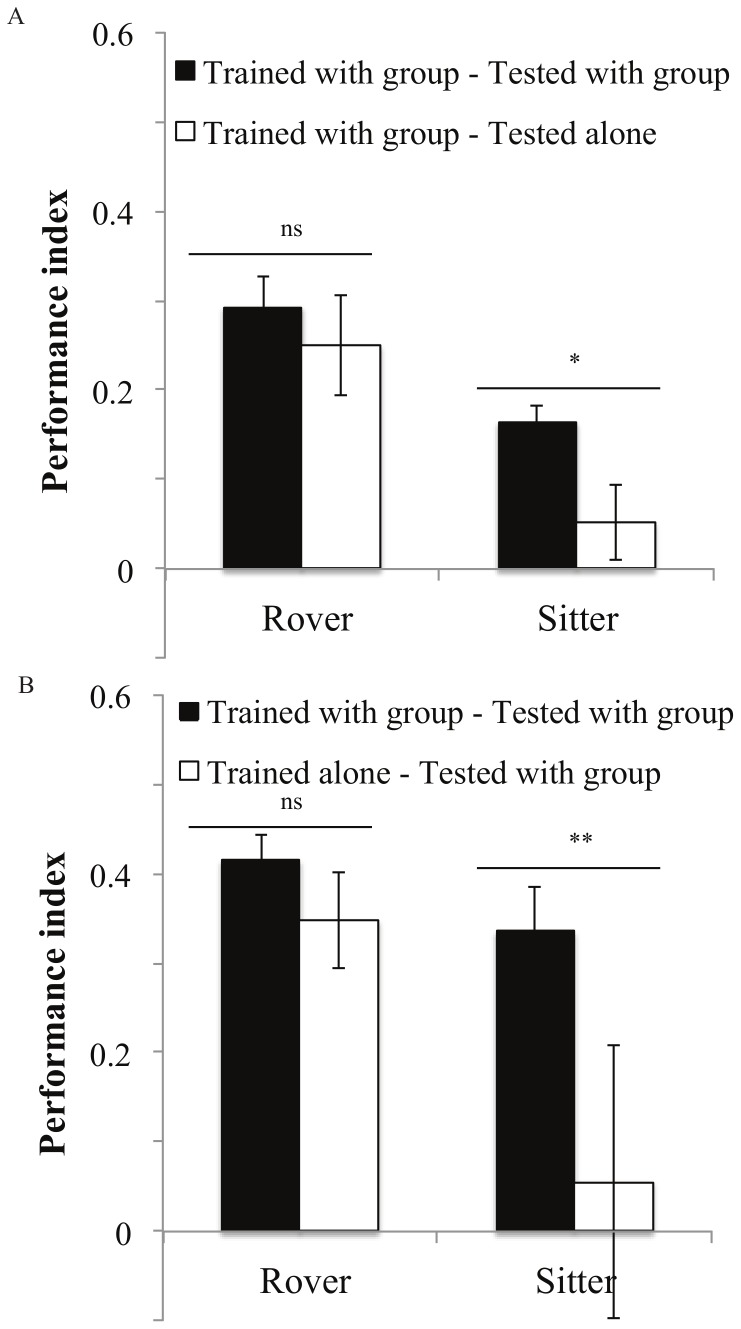
Performance of rovers and sitters when the training and testing were performed under different social contexts.
A: flies were trained in groups and then either tested in groups of the same genotype or individually. Rover: group: PI = 0.3±0.03 N = 23 PI; alone: PI = 0.25±0.05 N = 12 PI. Sitter: group: PI = 0.16±0.01 N = 24 PI; alone: PI = 0.05±0.04 N = 16 PI. B: flies were trained individually or in groups and then tested within a trained group of the same genotype. Rover: group: PI = 0.41±0.03 N = 25 PI; alone: PI = 0.34±0.05 N = 7 PI. Sitter: group: PI = 0.33±0.05 N = 21 PI; alone: PI = 0.05±0.15 N = 6 PI. Error bars represent ±SEM. Comparison between treatments. ns: P>0.05; *: P<0.05; **: P<0.01; ***: P<0.001.